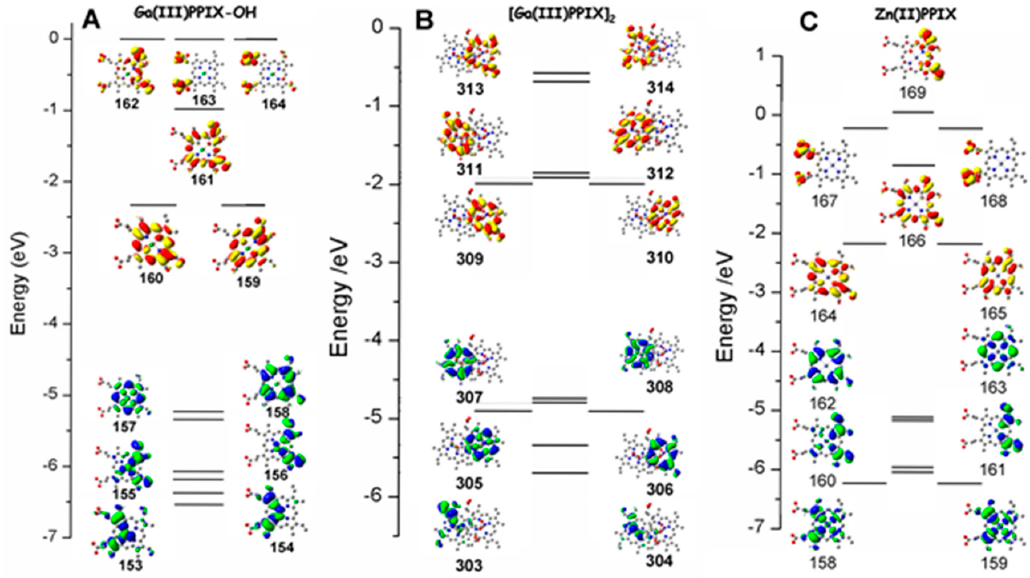
Figure 8. Top six highest occupied and lowest six unoccupied MOs for ( A ) Ga(III)-PPIX(OH) (orbitals 153–164), ( B ) the Ga(III)-PPIX dimer {(Ga(III)-PPIX) 2 } (orbitals 303–314) and ( C ) Zn(II)-PPIX (orbitals 158–169). The energies were calculated using density functional theory (DFT) methods: B3LYP/LANL2DZ. Shown are the energies and molecular orbital surfaces for the top six occupied MOs (green and blue phases) and the lowest six unoccupied MOs (red and yellow phases). Hydrogens have been omitted from structures for clarity. The lowest shown molecular orbital for Ga-PPIX is HOMO-5 at 153, for (Ga-PPIX) 2 is HOMO-5 at 303, and for Zn-PPIX is HOMO-5 at 158. Reproduced with permission of the American Chemical Society [98].